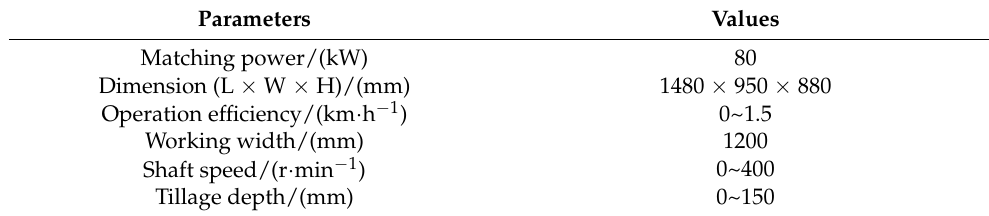
Table 1. Main parameters of reverse rotary tiller.